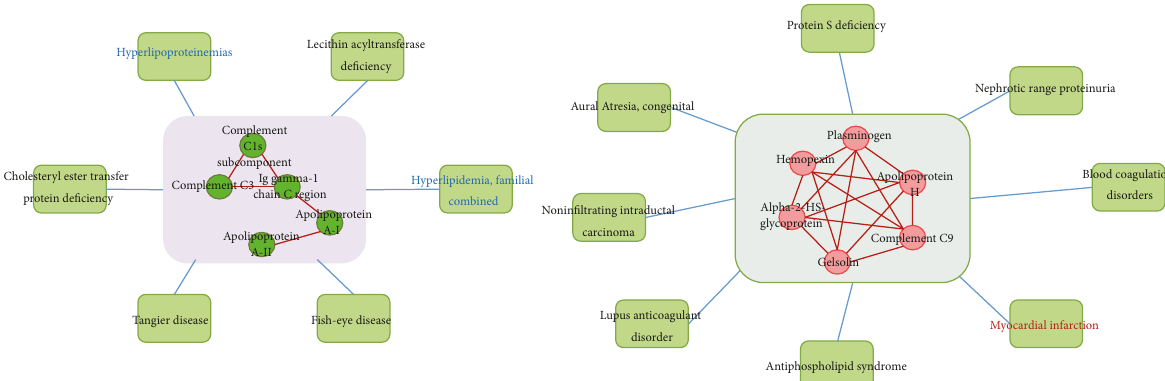
Figure7: Disease-associatednetworks for two HDL subspecies .Each HDL subspecies islinked toitsassociated diseases(squarenodes).Disease labels are marked with pink text (CVD-related), blue text (dyslipidemia-related), and black text